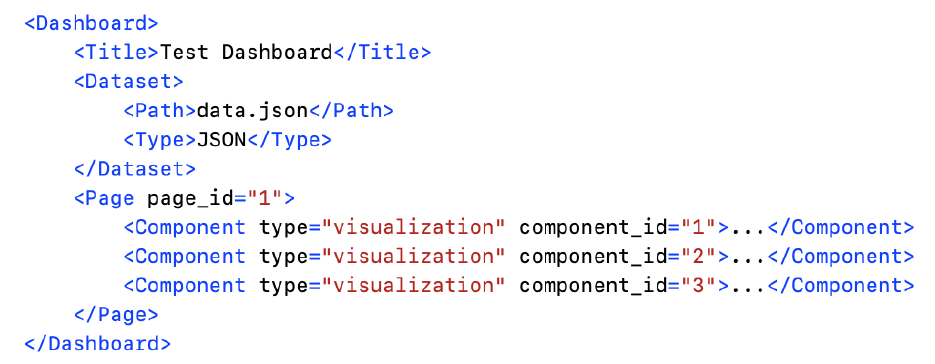
Figure 7. Configuration of a dashboard using the DSL.